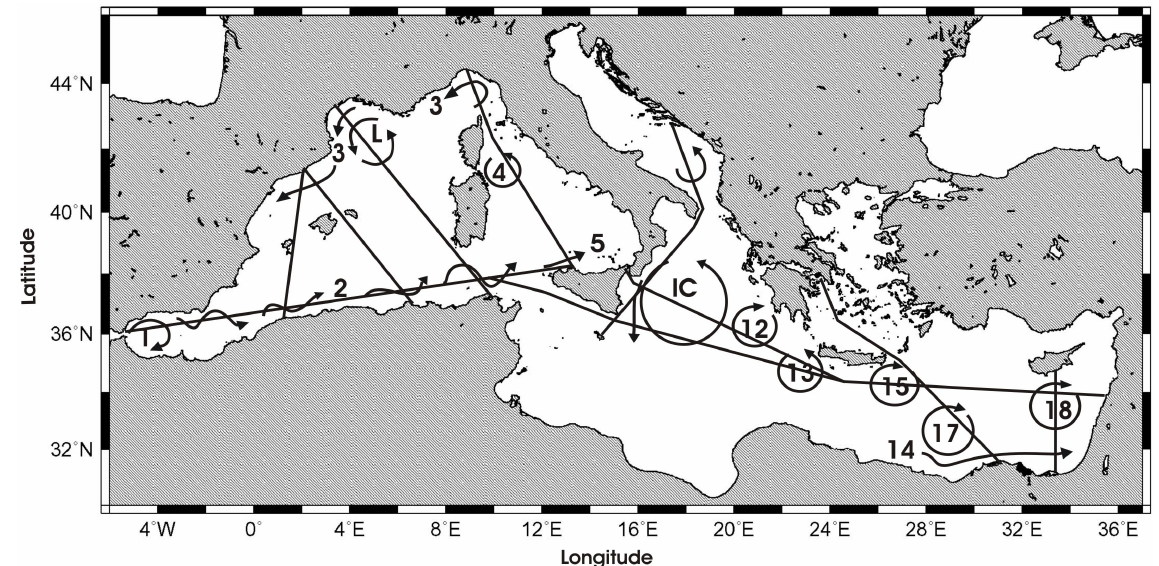
Fig. 10. Upper layer circulation from XBT data. Numbers and letters indicate the observed features: 1-Western Alboran Gyre, 2-Algerian Current, 3-Liguro-Provenc¸o-Catalan Current, 4-Bonifacio Gyre, 5-Tyrrhenian Current, L-Gulf of Lions Gyre, IN-Ionian Cyclone, A-South Adriatic Gyre, 12-Pelops Anticyclone, 14-Mid-Mediterranean Jet, 15-Ierapetra Anticyclone, 17-Mersa-Matruh Gyre, 18-Shikmona